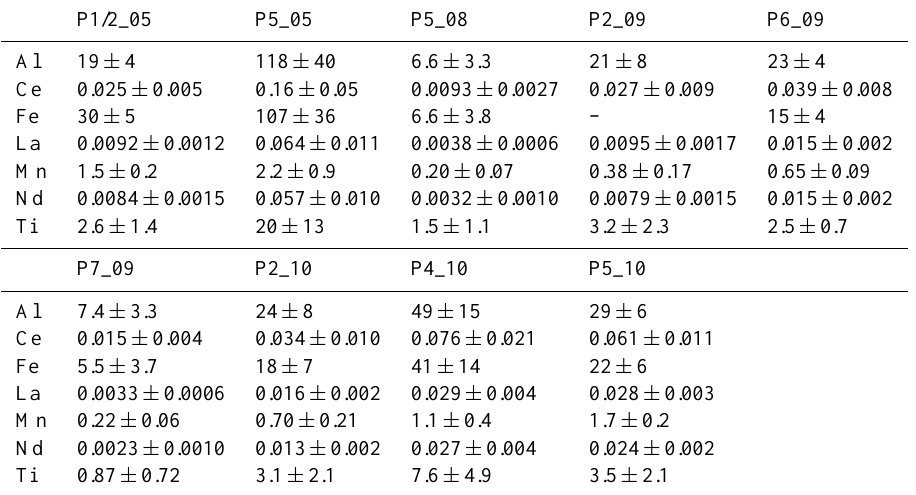
Table 3b. Rain event fluxes (µgm − 2 ) ± uncertainties, deduced from measurements of samples identified as contaminated by local